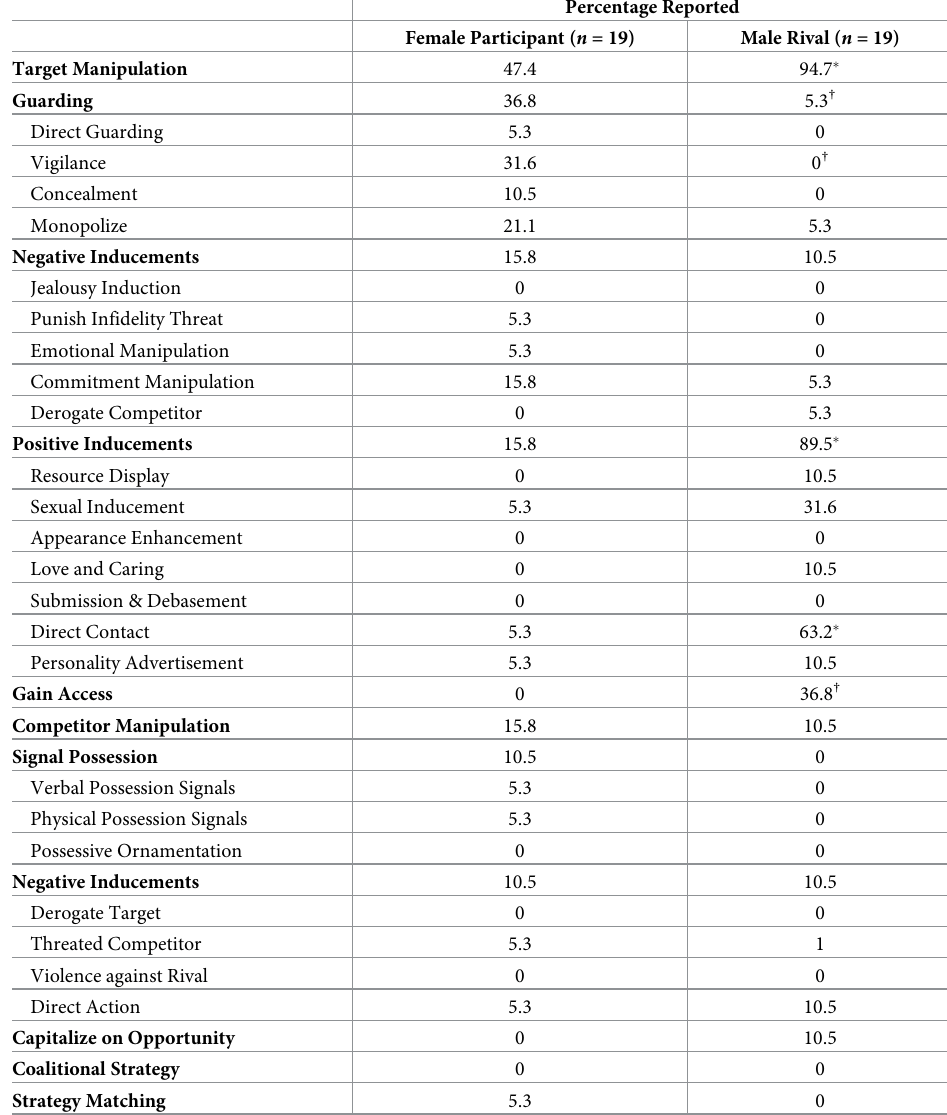
Table 1. Inter-sexual mate competition retention/poaching tactics in